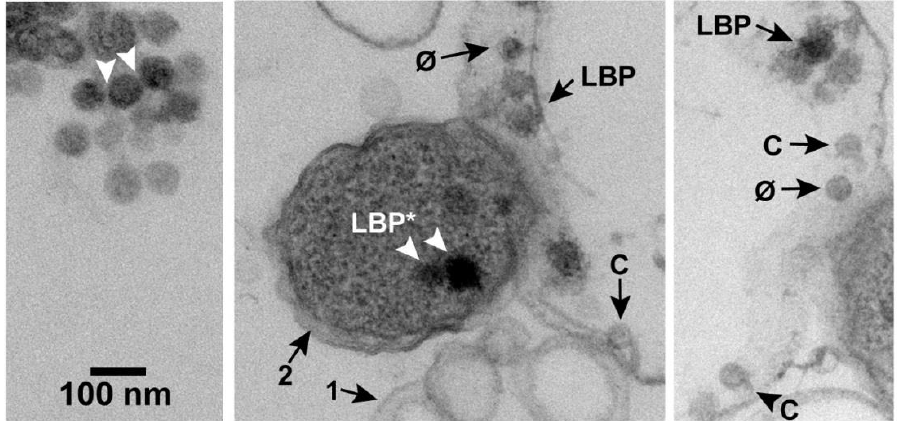
Figure 2. An image obtained by EM-TS of a phage T3 plaque. Annotations are described in the text. Uranyl acetate/lead staining was used. C, capsid; φ, phage; LBP, larger-than-phage black particle.